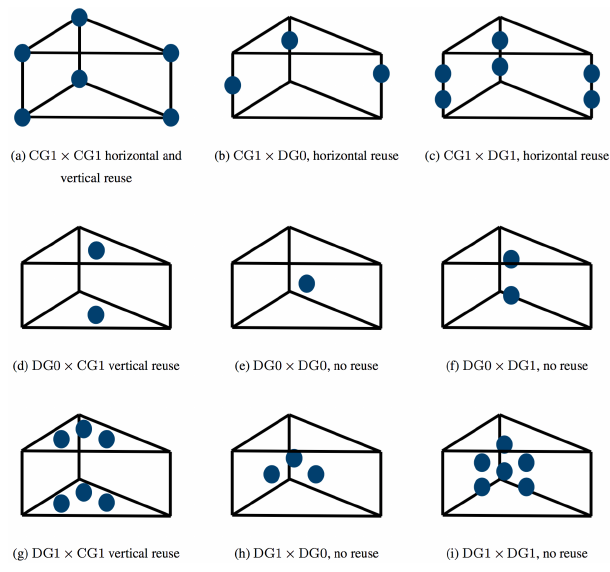
Figure 5. Tensor product finite elements with different data layout and cell-to-cell data re-use.